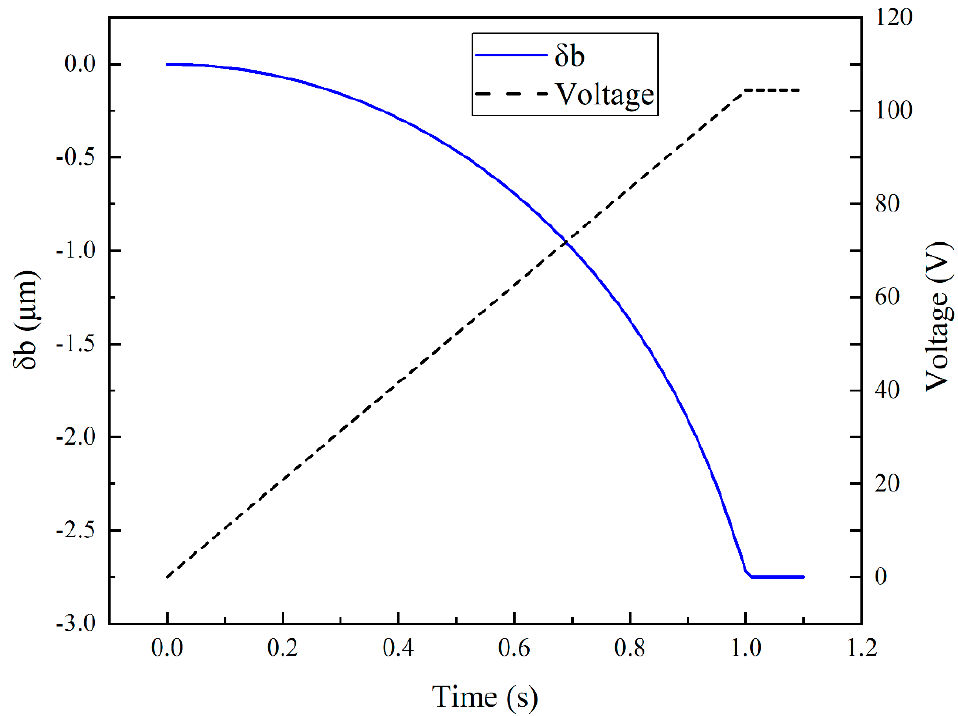
Figure 4. Transient vertical displacement at the free end of the cantilever beam and the driving volt- age.